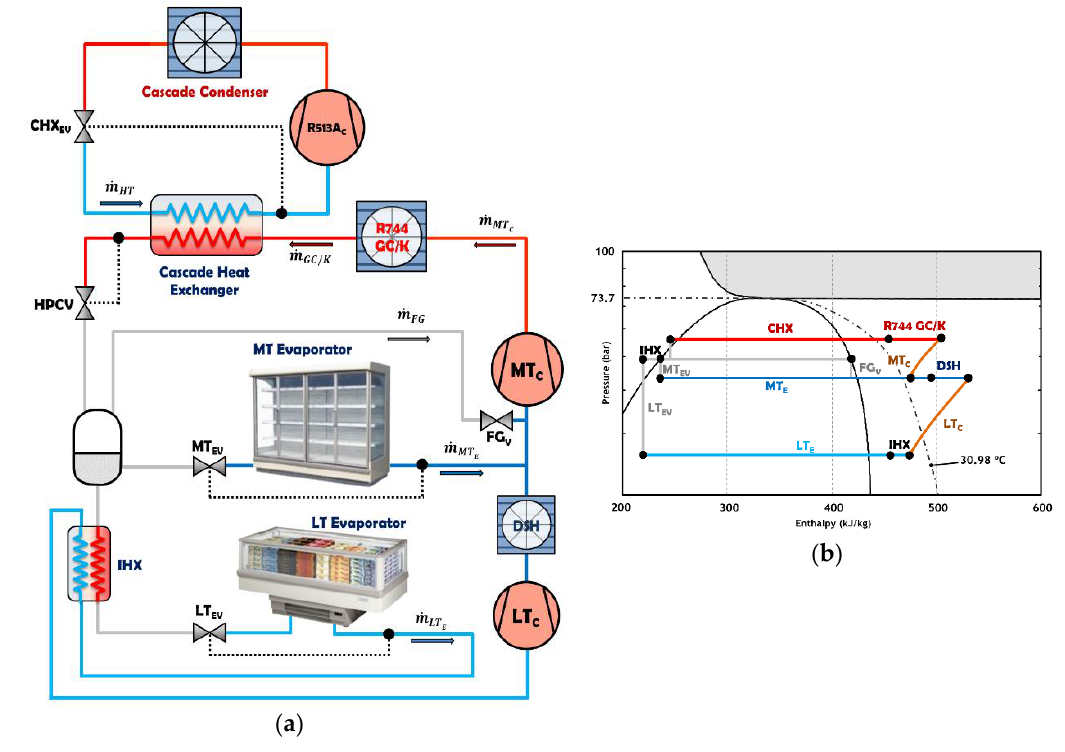
Figure 5. Schematic of a cascade with subcritical booster ( a ) and its R744 p–h diagram ( b ).